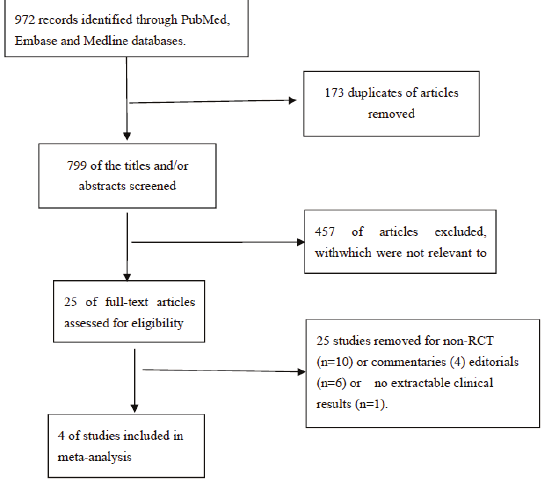
Figure 1: Search strategy conducted for all included trials. Abbrevia- tions: MeSH, medical subject